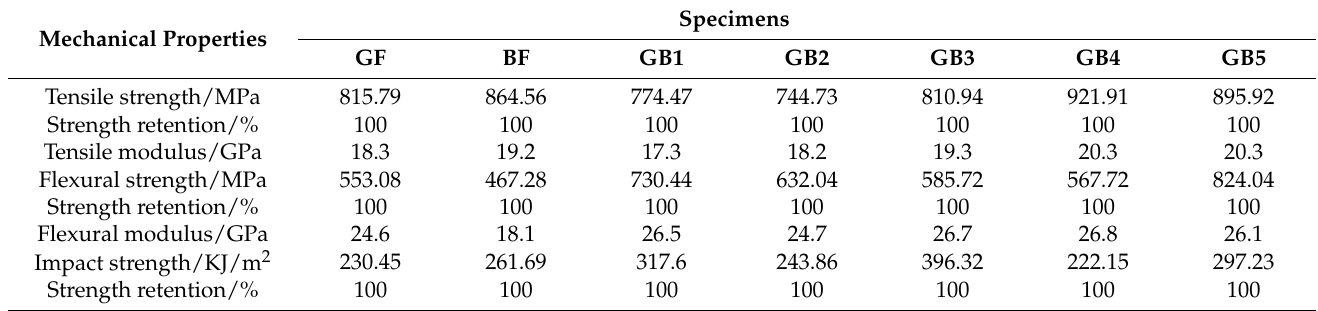
Table 3. Mechanical properties of plain and hybrid specimen before seawater ageing.